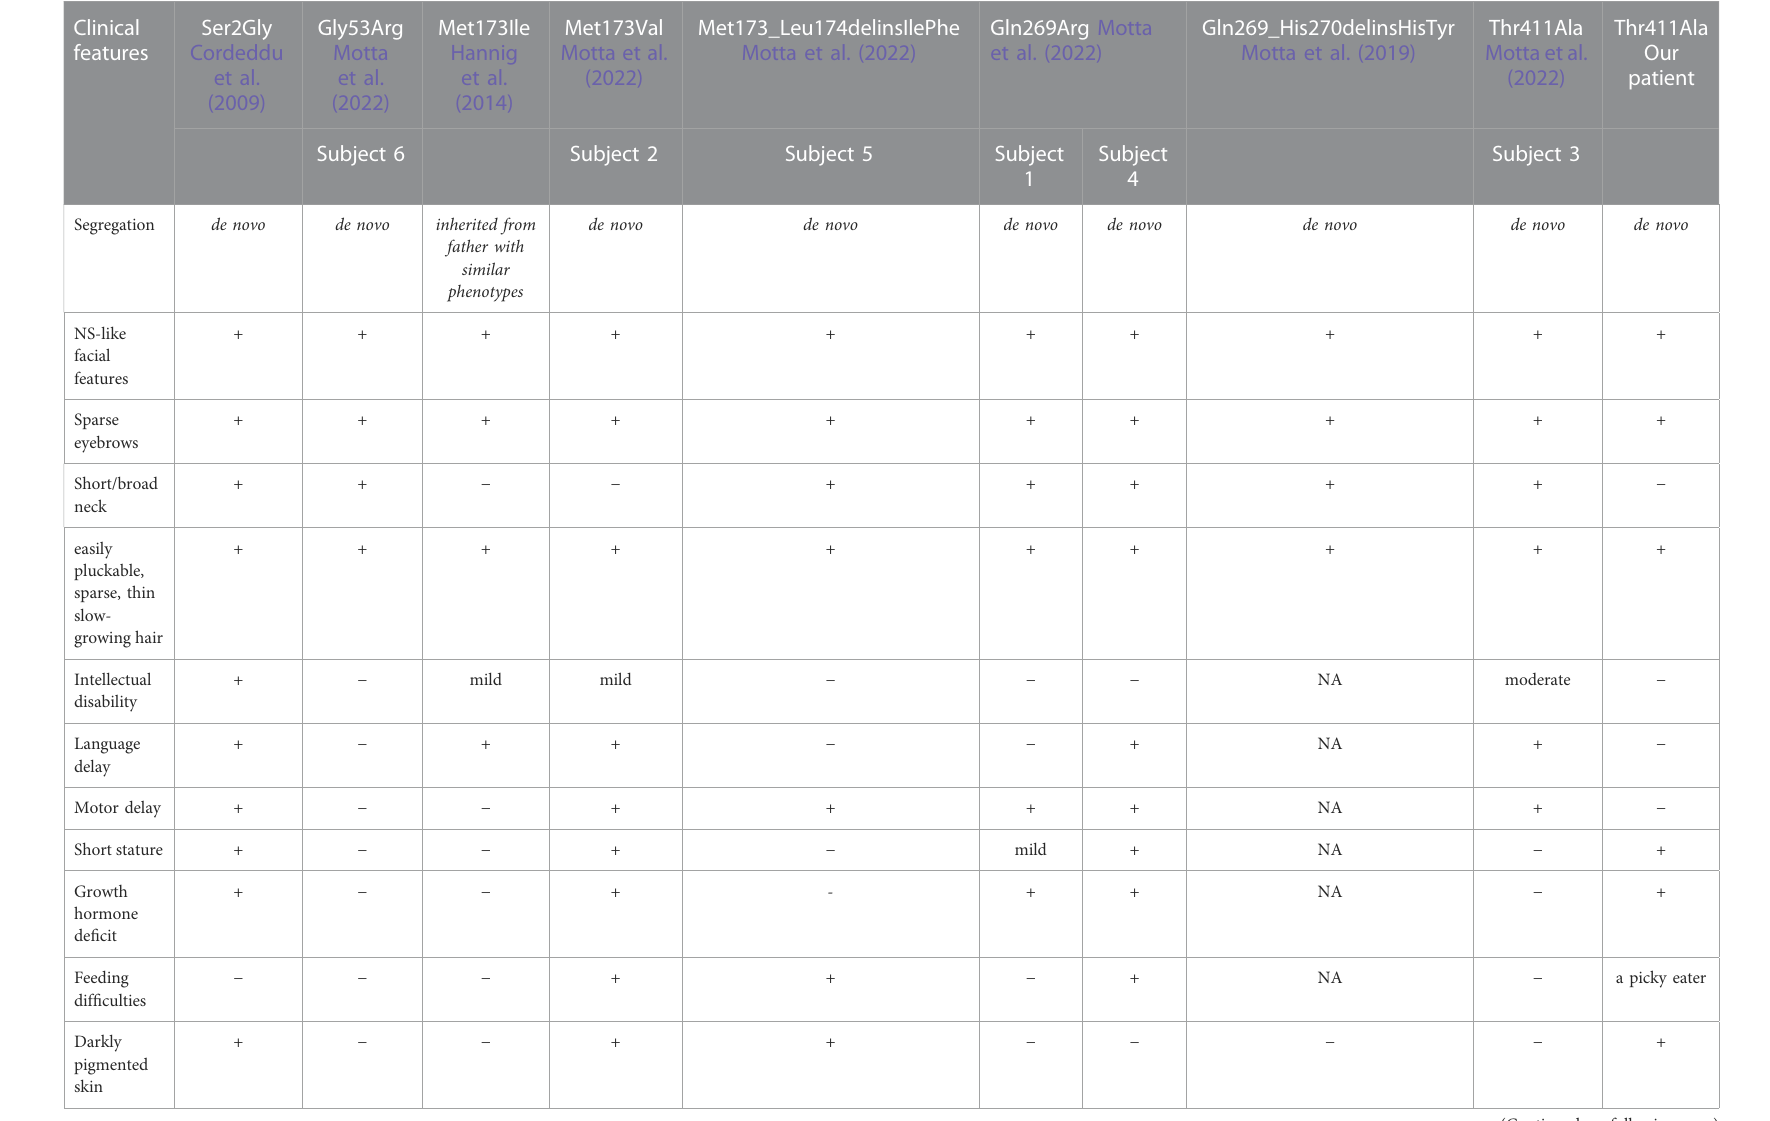
TABLE 1 Overview of variants and phenotypes observed in patients with